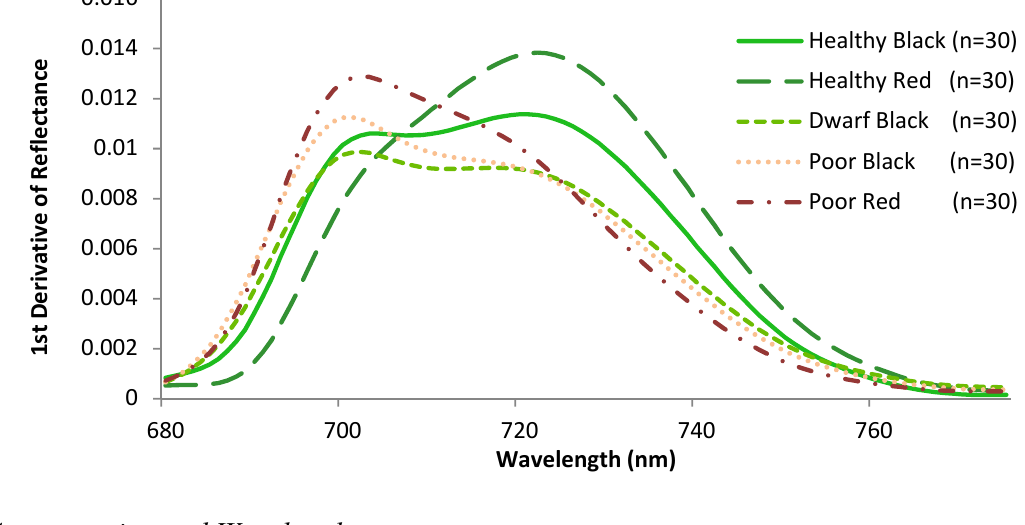
Figure 6. The first derivative reflectance of mean mangrove spectral response. The highest derivative value indicates the position of the red edge inflection point.